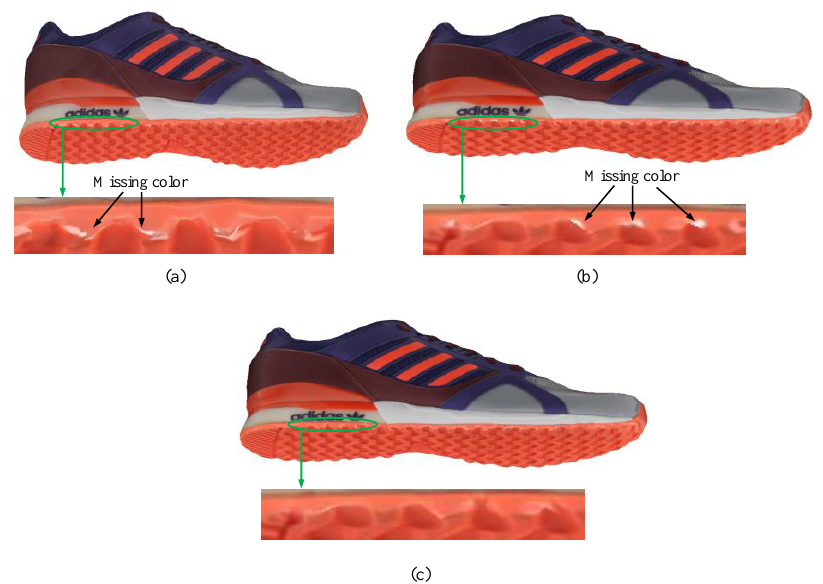
Figure 14. Implementation of the proposed algorithm to remove missing colors: ( a ) 3DSOM software ( b ) before and ( c ) after.